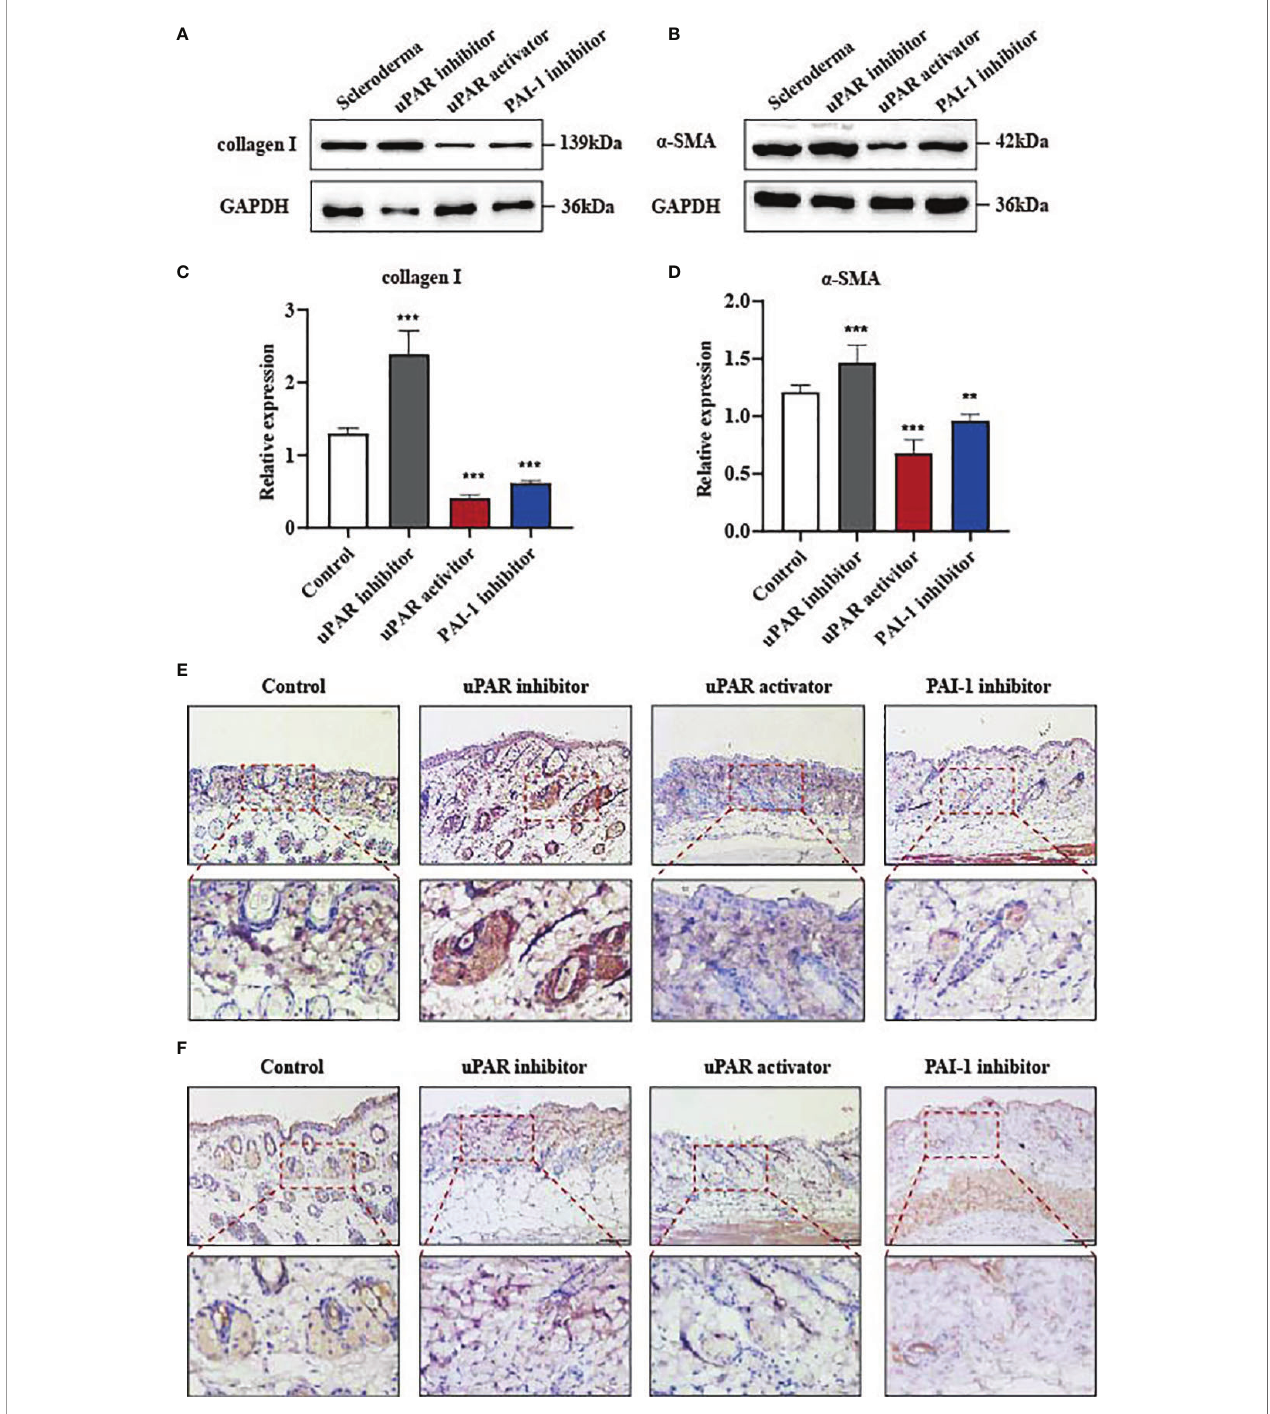
FIGURE 5 | Inhibition of PAI-1 and the addition of uPA inhibit the expression of fi brosis associated proteins in vivo. (A, B) The proteins of a -SMA and type I collagen were detected from skins of mouse models by western blot assay. (C, D) Quanti fi cation of (A, B) . (E) Skin tissues were immunohistochemically stained for type I collagen. Scale bar, 100 mm. (F) Skin tissues were immunohistochemically stained for a -SMA. Scale bar, 100 mm. **P < 0.01 and ***P < 0.001 when compared between the denoted